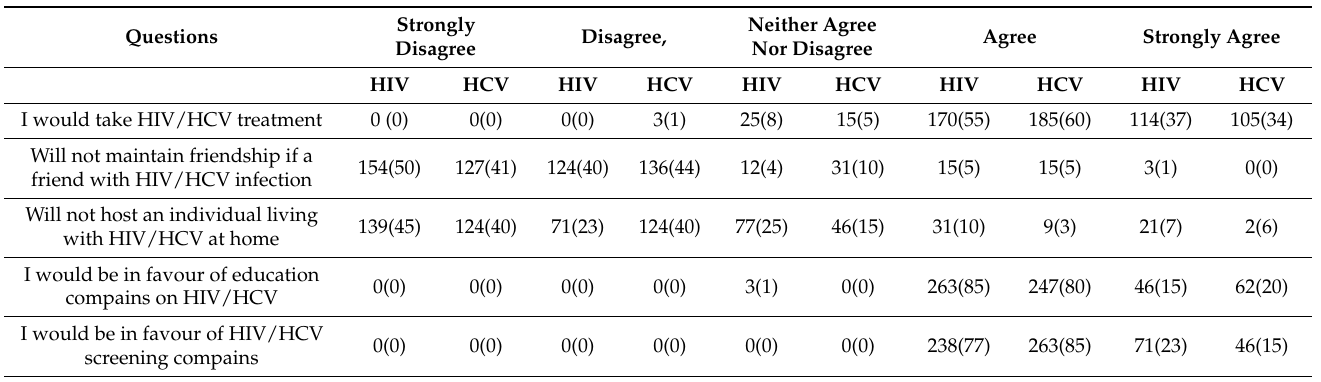
Table 3. Attitude about HIV and HCV.